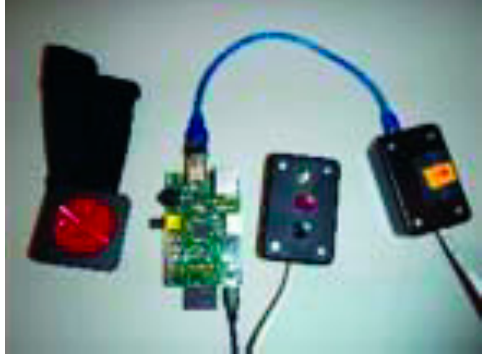
Figure 14. The prototype of the proposed device [34].